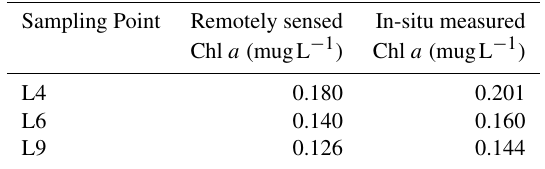
Table 2. Summary of the estimated water quality variables. Table 3. Validation of Chlorophyll a